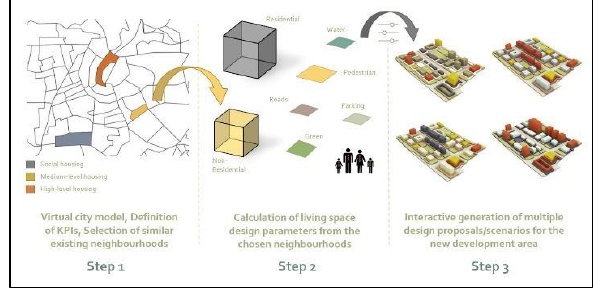
Figure 2. Overview of the proposed methodology.